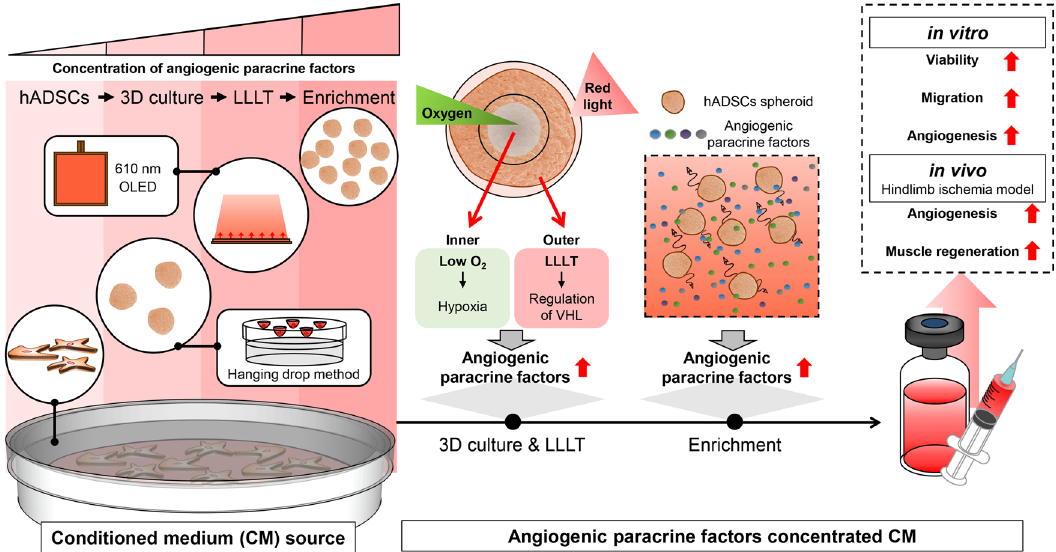
Fig. 1 Schematic illustration showing the production of conditioned medium (CM) for ischemic disease therapy. Left, Center : Preparation of CM enriched with ischemic disease targeting-angiogenic paracrine factors obtained from human adipose-derived stem cells (hADSCs). Right : Positive effects relevant to the treatment of ischemic disease are